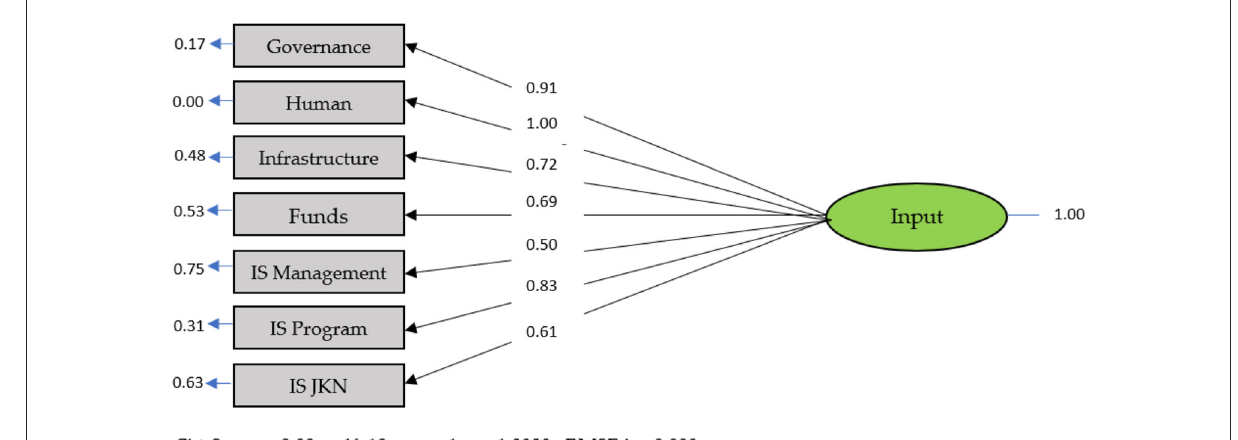
FIGURE2 Standard input model solution.